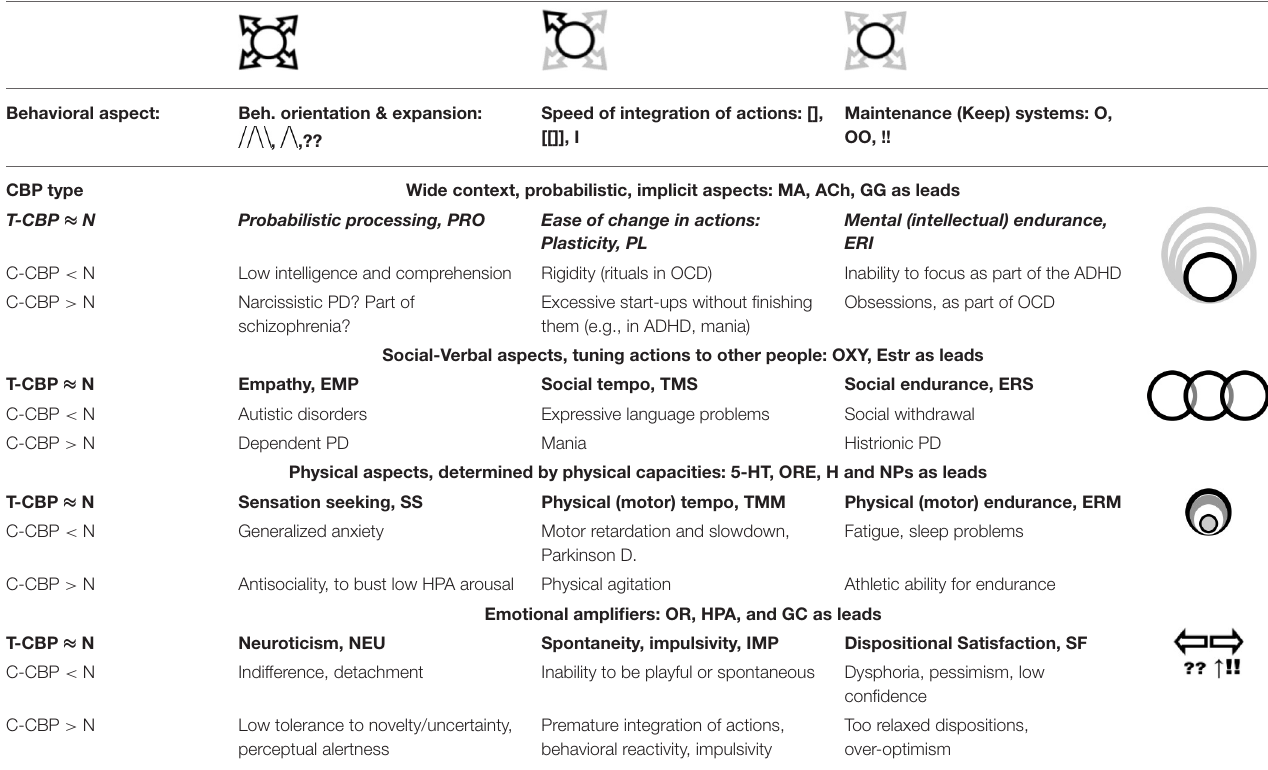
TABLE 2 | The neurochemical model FET (Functional Ensemble of Temperament, T-CBP), highlighted in italic-bold and the comparison of its component to clinical consistent behavioral patterns (C-CBP).